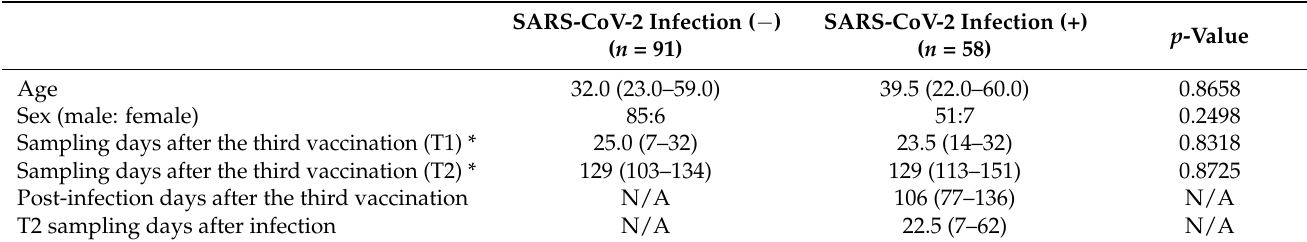
Table 1. Characteristics and demographics of participants with the third dose of COVID-19 vaccina- tion, regarding SARS-CoV-2